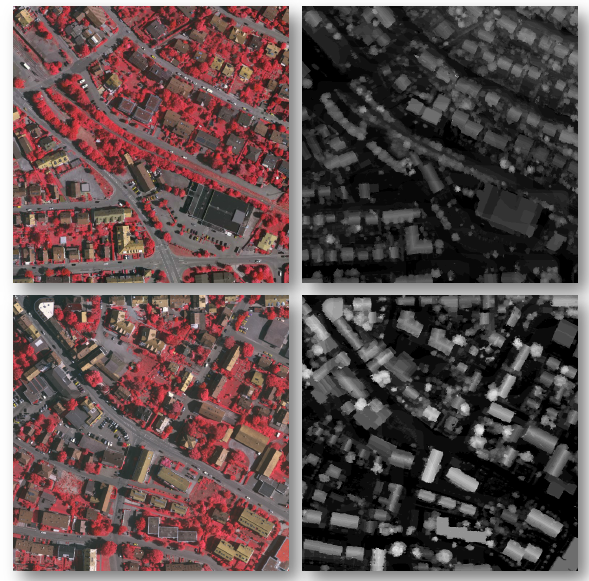
Figure 3. False-color image tiles (left column) and corresponding normalized DSMs (right